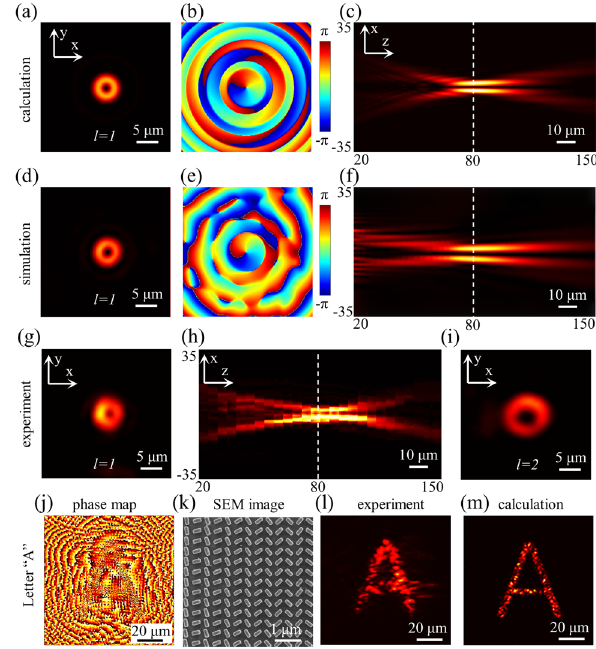
Figure 3: Chip integrated focused vortex beam generation (Figure 3(a) – (i)) and hologram generation (Figure 3(j) – (m)) by geometric metasurfaces based on LNOI waveguide. Theoretical calculations ( l = 1) of (a) intensity distribution and (b) phase distribution on the focal plane, (c) intensity distribution in propagation plane. (d) – (f) Corresponding simulation results performed by FDTD solutions. (g) Experimentally measured OAM beamintensitydistribution(characteristicdonutshape)onthefocal plane. (h) Reconstructed intensity distribution in x - z propagation plane.(i)ExperimentallymeasuredOAMbeamwith l =2,whichhasa larger radius of the donut shape. (j) Calculated phase distribution of the hologram of letter “ A ” . (k) SEM image of part of the fabricated structures. (l) and (m) Reconstructed holographic image compared with the theoretical